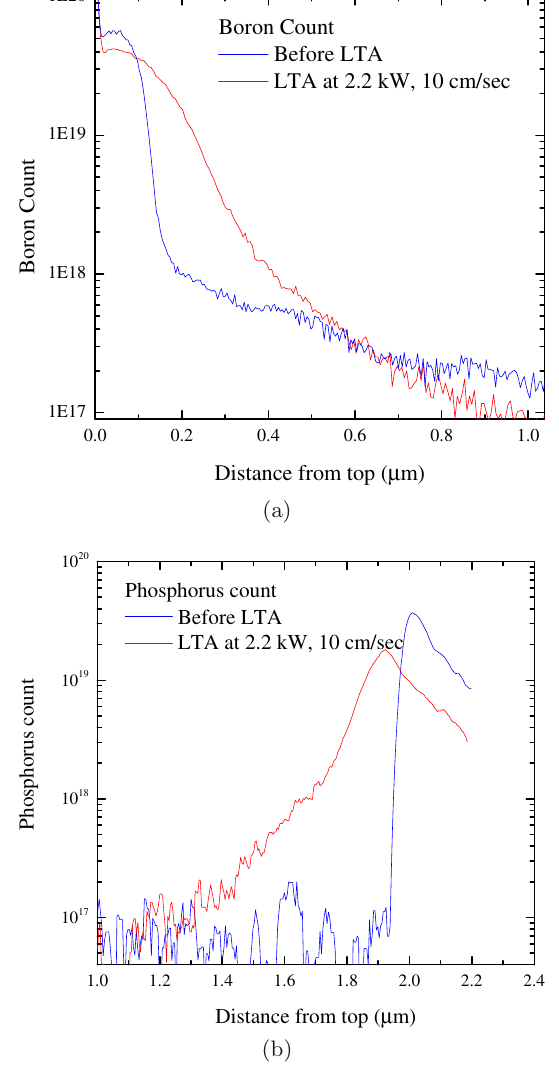
Fig. 7. SIMS study on the samples before and after LTA: (a) boron count, (b) phosphorus count.